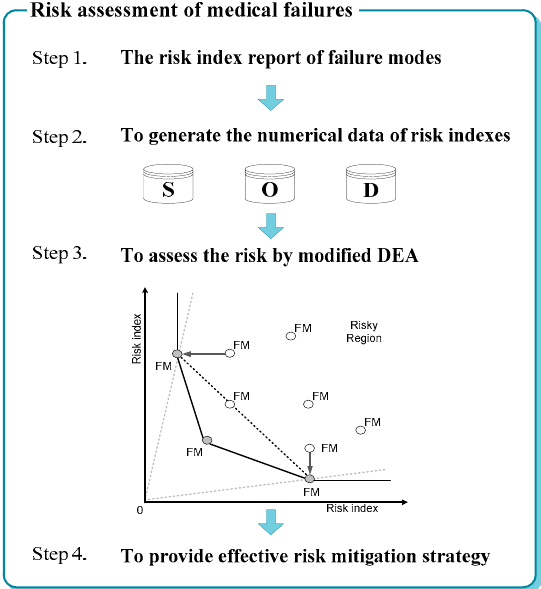
Figure 1. The process of risk assessment. DEA: data envelopment analysis.